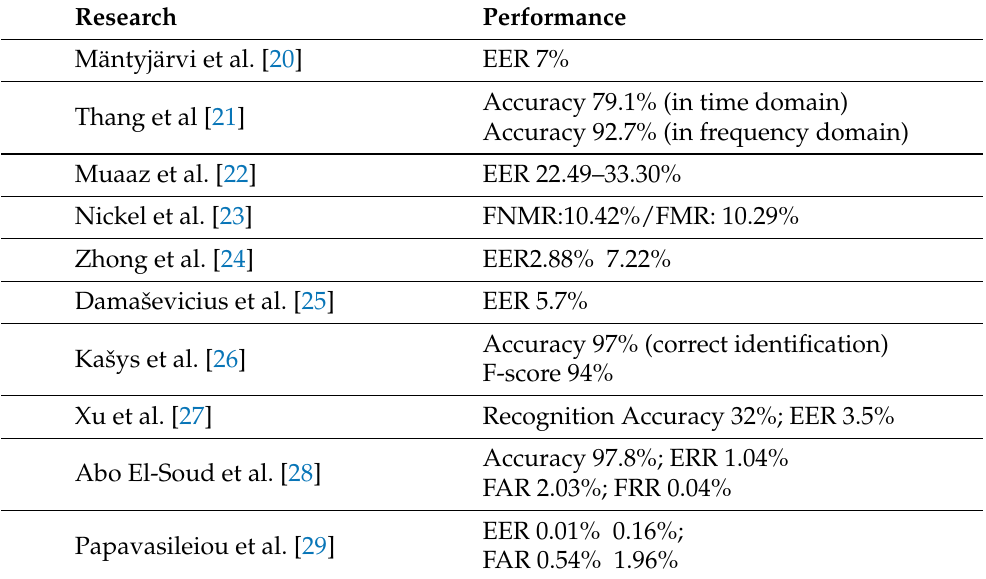
Table 2. Key gait-based implicit authentication methods for mobile